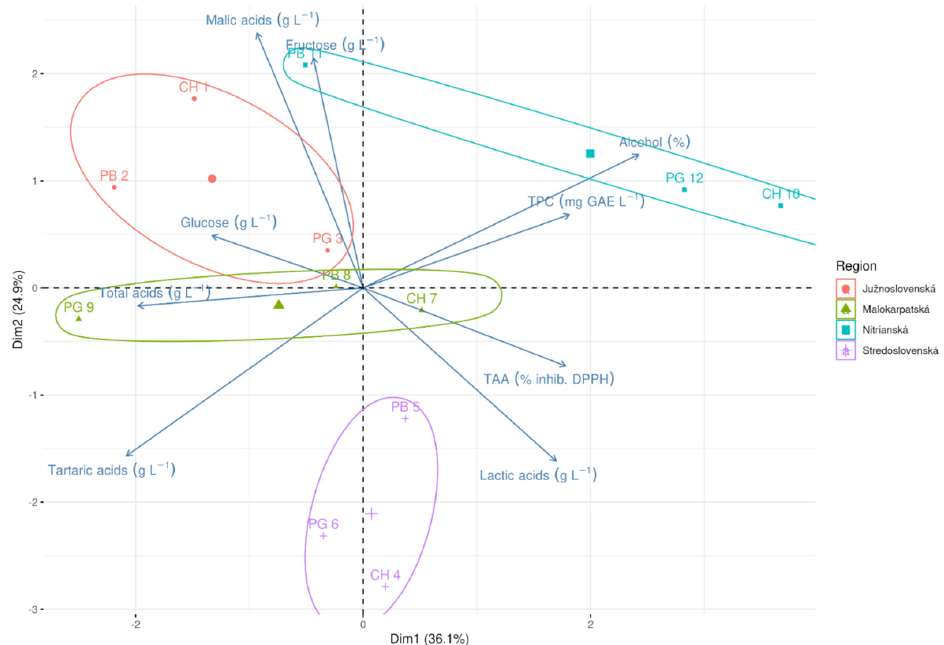
Figure 2. PCA bi-plot of wines with chemical parameters grouped by wine regions. Statistical tests confirmed significant differences in selected chemical parameters in relation to the wine-growing regions (Figure 3). Differences among regions were confirmed in total acids (F 3,8 = 6.7, p = 0.0142), caused mainly by differences between the Nitrianska and Južnoslovensk á wine regions (t 8 = 4.37, p = 0.01). Content of tartaric acid was also statistically different (F 3,8 = 9.8, p = 0.0046) due to the low content in the Nitrianska wine region compared to the values in Južnoslovensk á (t 8 = 4.2, p = 0.013) and Stredoslovensk á wine region (t 8 = − 5.1 p = 0.004). In the case of malic acid (F 3,8 = 21.7, p = 0.0003), significant differences were discovered between Južnoslovensk á and every other region (t 8 = 5.1; 3.3; 7.9, p < 0.05, for Malokarpatsk á , Nitrianska and Stredoslovensk á , respectively) as well as between Nitrianska and Stredoslovensk á wine regions (t 8 = 4.6 p = 0.008). Content of alcohol was also statistically different (F 3,8 = 19.208, p = 0.0005) due to the difference between Južnoslovensk á and Nitrianska region (t 8 = − 5, p = 0.013), Malokarpatsk á and Nitrianska region (t 8 = − 6.77, p = 0.0006), and Nitrianska and Stredoslovensk á region (t 8 = 6.3, p = 0.001). Lastly, significant differences were also confirmed in glucose levels (F 3,8 = 10.8, p = 0.0035), mainly between the Južnoslovensk á and Nitrianska wine regions (t 8 = 3.4, p = 0.04), the Južnoslovensk á and Stredoslovensk á wine regions (t 8 = 3.5, p = 0.03), the Malokarpatsk á and Nitrianska wine regions (t 8 = 4.4, p = 0.009) and the Malokarpatsk á and Stredoslovensk á wine regions (t 8 = 4.5, p =